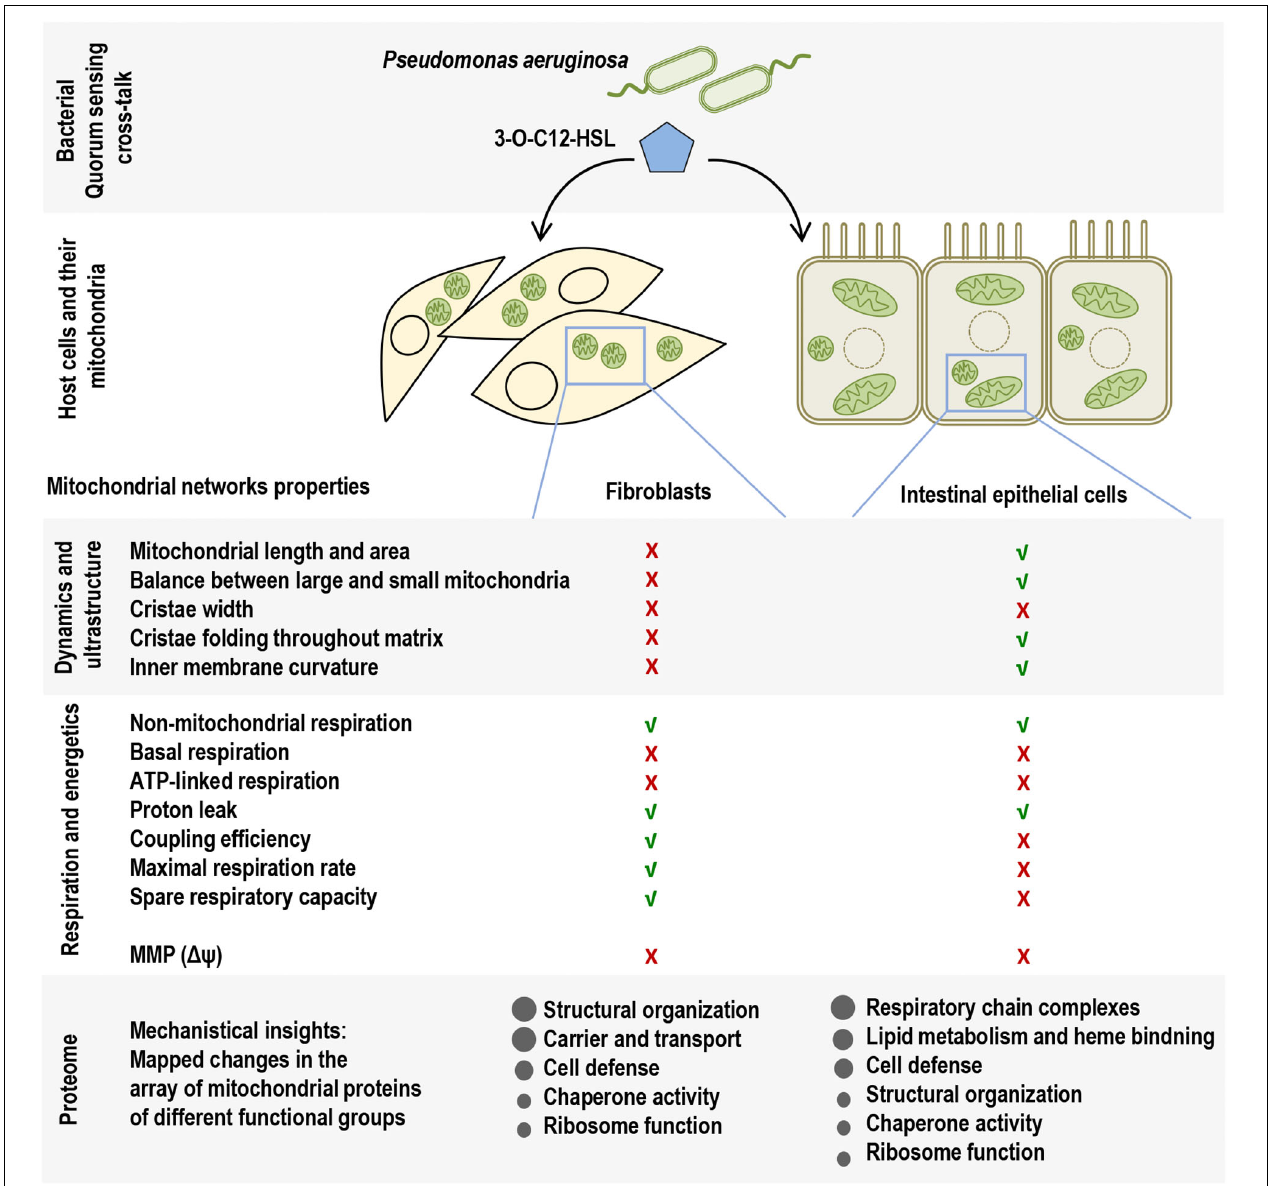
FIGURE 9 | Overview of the study on the impact of P. aeruginosa QS molecule 3O-C 12 -HSL on mitochondrial morphology, energetics, and proteome in host cells. In the upper panel, the scheme illustrates main QS molecule 3O-C 12 -HSL (blue pentagon) of P. aeruginosa that together with other signals in the QS system provides cell–cell communication between bacteria and control biofilm development, virulence traits, adaptation and interactions with the host. QS molecules, like 3O-C 12 -HSL, can modulate the behavior of host cells and their mitochondrial networks, e.g., in the two types of cells used in this study, fibroblasts and intestinal epithelial cells. In the middle panels, the scheme summarizes multifactorial impact of 3O-C 12 -HSL on mitochondrial dynamics, ultrastructure, respiration and energetics, and that there are distinct cell-type specific details and strength of these effects. Mitochondrial properties and functions similar to those in the controls are depicted by green check mark, and those that were affected or disrupted depicted with red cross. The lower panel reflects mechanistical insights and mapped changes in a common and cell-type specific array of components in the mitochondrial